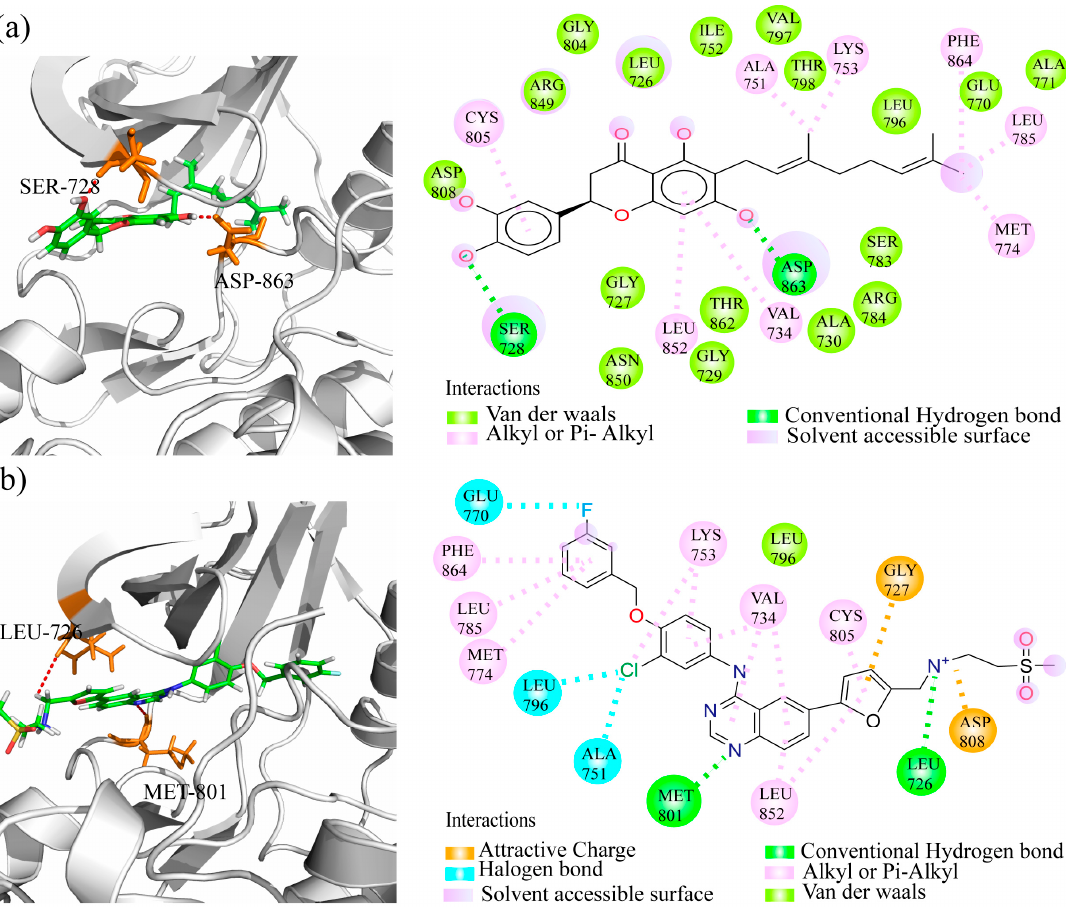
Figure 6. Comparison of binding models of lapatinib and ZINC15122021 against HER2 at atomic level. ( a ) the interaction of ZINC15122021 with HER2; ( b ) the interaction of lapatinib with HER2. The 2D diagram interactions were shown as dashed lines between receptor residues and ligand atoms. The figures were generated by the PyMOL1.5 (The PyMOL Molecular Graphics System, San Carlos, CA, USA) and Discovery Studio visualizer 16 (Accelrys, San Diego, CA, USA).